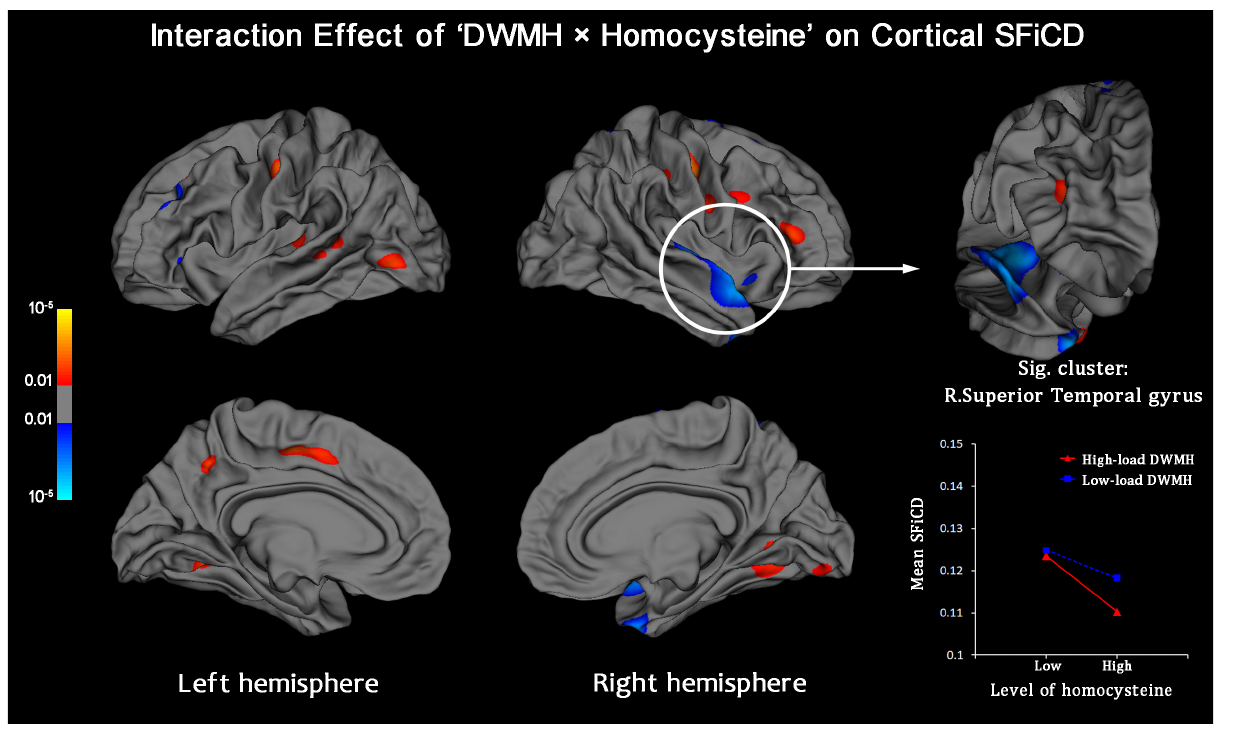
FIGURE 3 | Vertexwise analysis of the interaction effect between the factors “DWMH” and “Homocysteine” on the cortical SFiCD. The statistical map is thresholded with a vertex-level P < 0.01. The cluster that survived Monte Carlo simulation correction (cluster-level P < 0.01) is further marked with a circle. The right superior/transverse temporal gyrus showed a significant interaction effect.